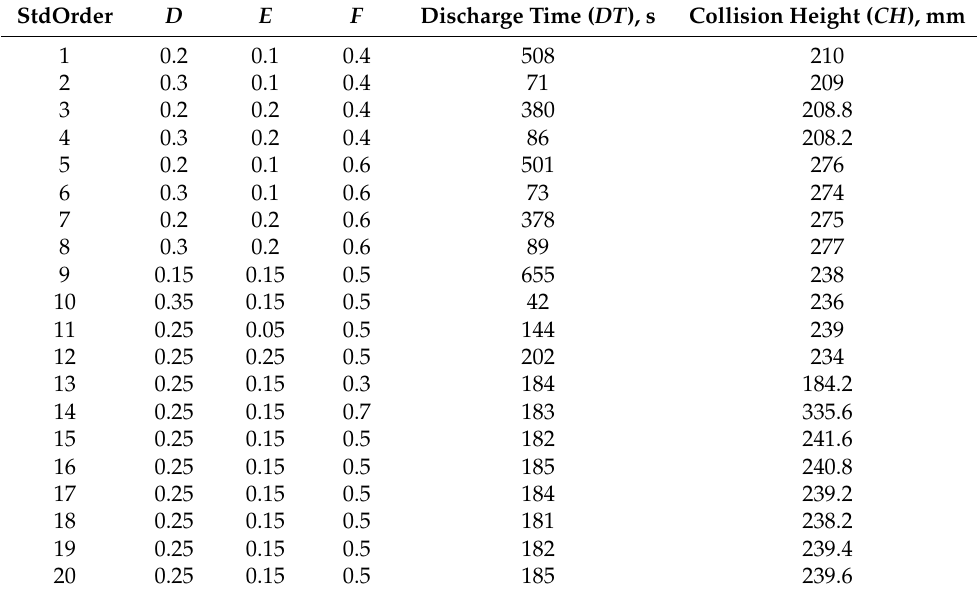
Table 8. Simulation results of the discharge-drop